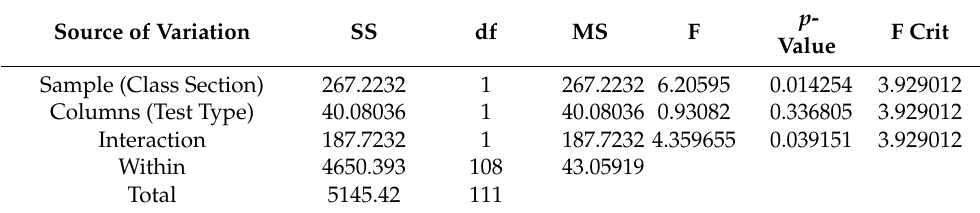
Table 5. Two Way ANOVA Pre and Post Drawing Assessment.